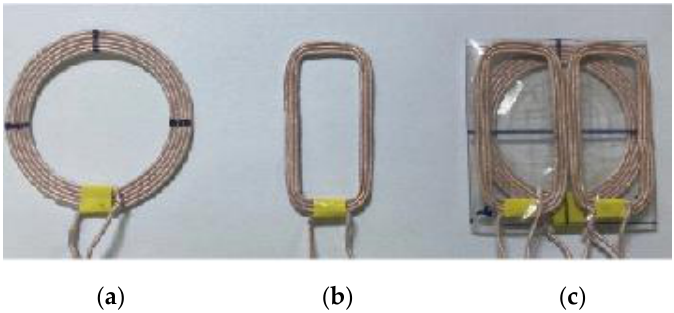
Figure 5. Photograph of the fabricated coils: ( a ) primary coil; ( b ) assistant coil; ( c ) multilayer